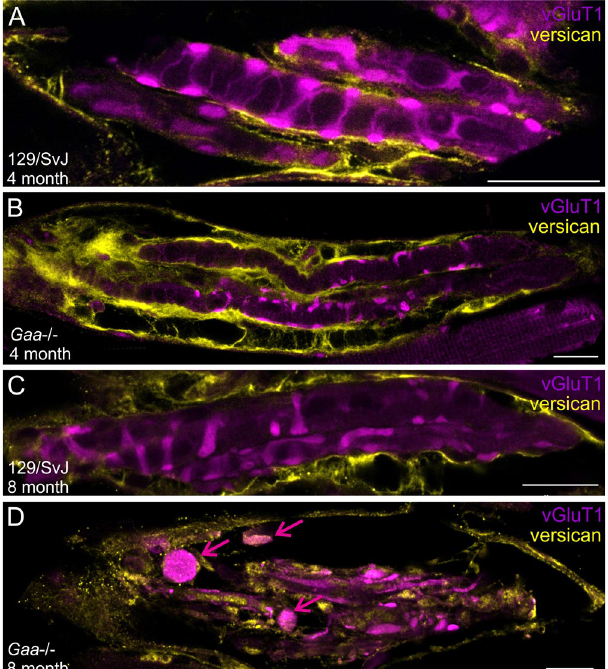
Figure 7. The muscle spindle connective tissue capsule deteriorates in 8-month-old Gaa −/− mice. Muscle spindles from 4- ( A,B ) and 8-month-old ( C,D ) wildtype ( A,C ) and Gaa −/− ( B,D ) mice were stained with antibodies against vGluT1 (purple channel) and the extracellular matrix protein versican (yellow channel). The antibodies labeled the inner and outer capsule of muscle spindles in wildtype and 4-month-old Gaa −/− mice. In 8-month-old Gaa −/− mice, the labeling was distributed throughout the muscle spindle and the inner- and outer capsule appeared fragmented. Note the vGluT1-positive varicosities (purple arrows in panel ( D )) and the punctate versican immunoreactivity in the 8-month-old Gaa −/− mice. Scale bar: 20